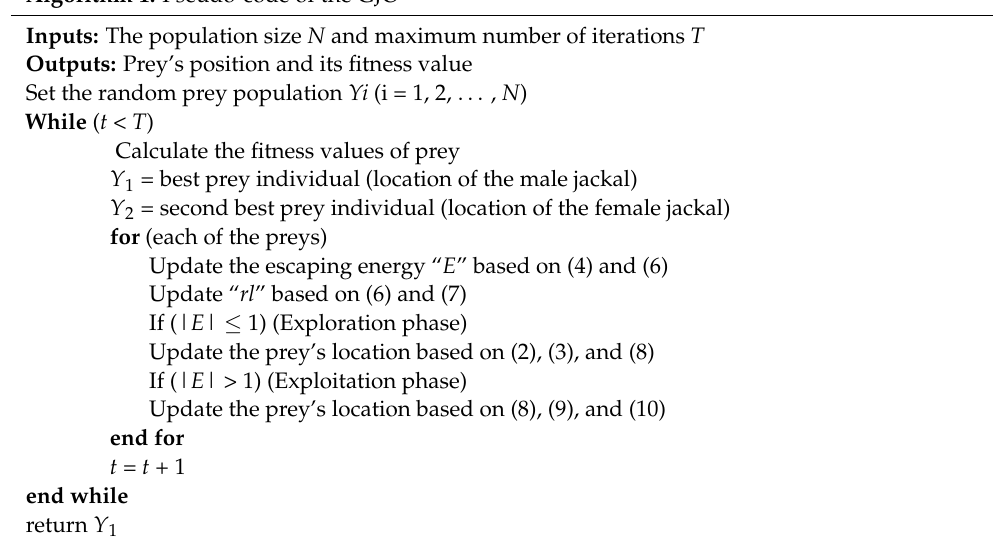
Algorithm 1. Pseudo-code of the